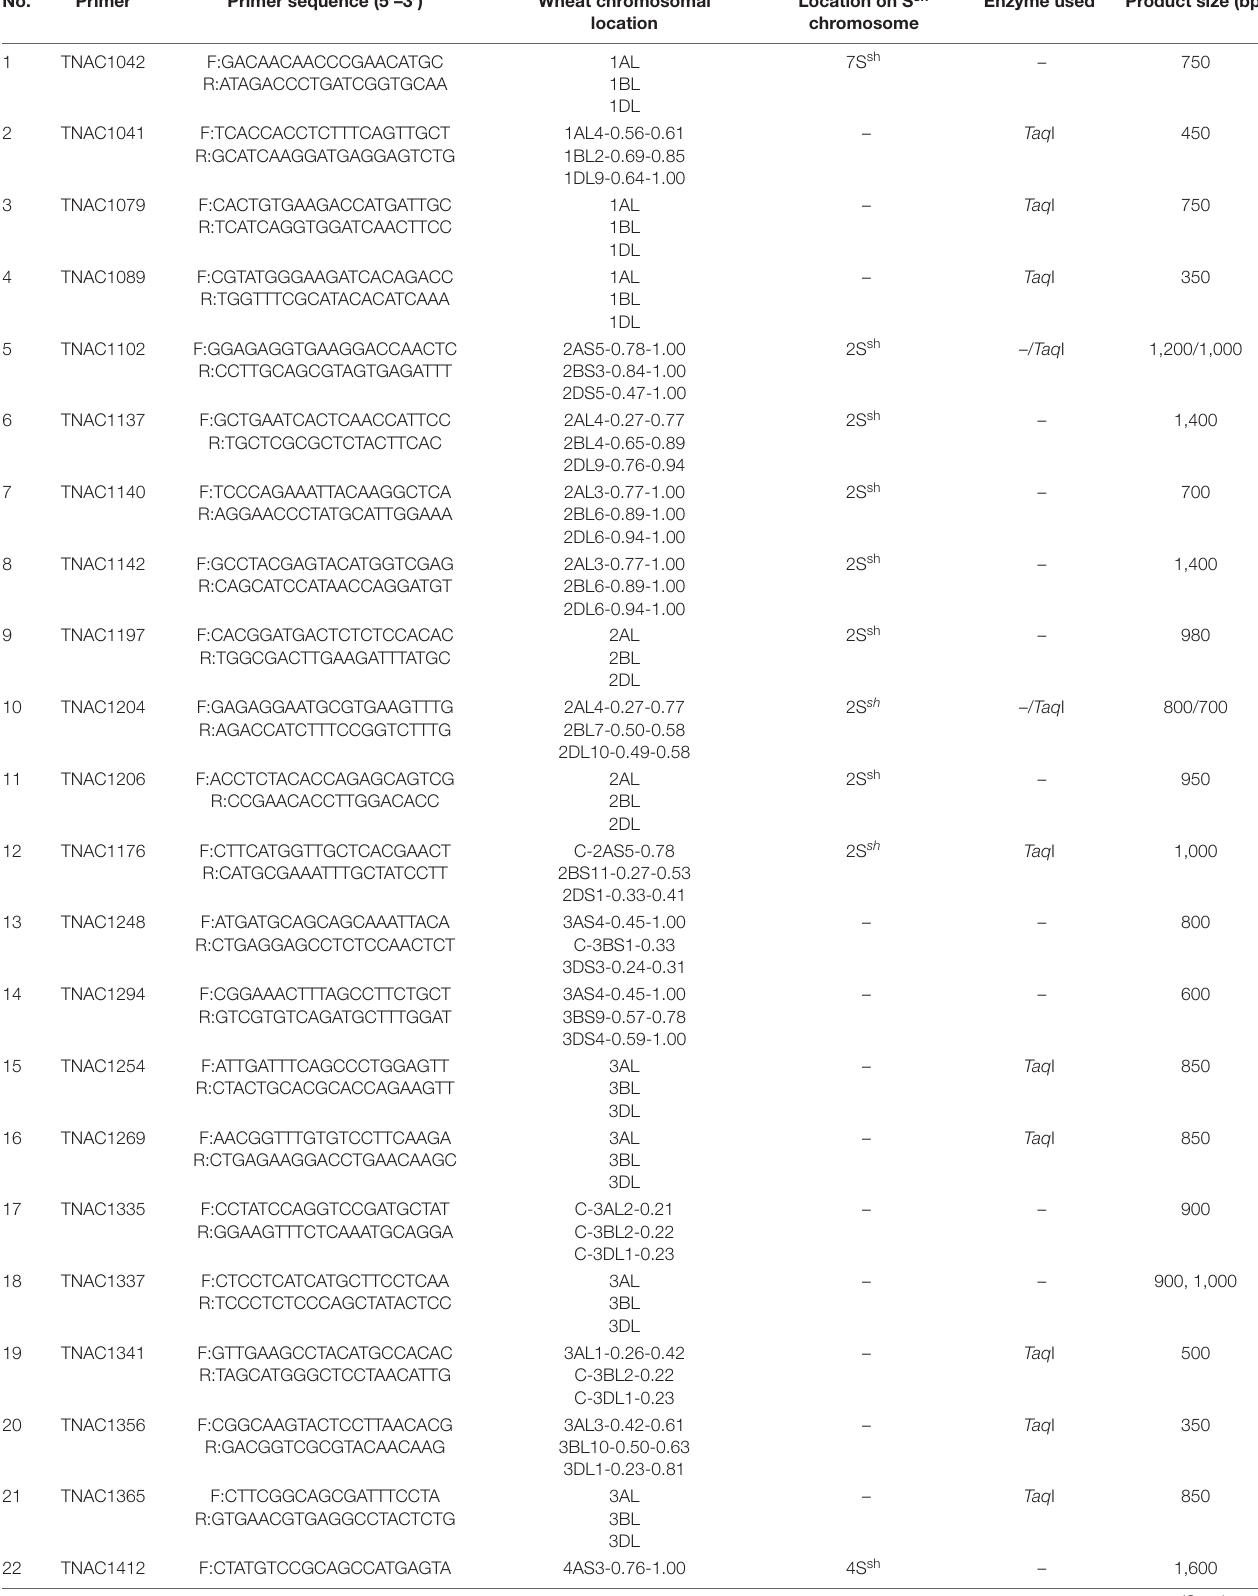
TABLE 2 | Markers specific for A. sharonensis chromosomes developed by the current study. No. Primer sequence (5 (cid:48) –3 (cid:48)